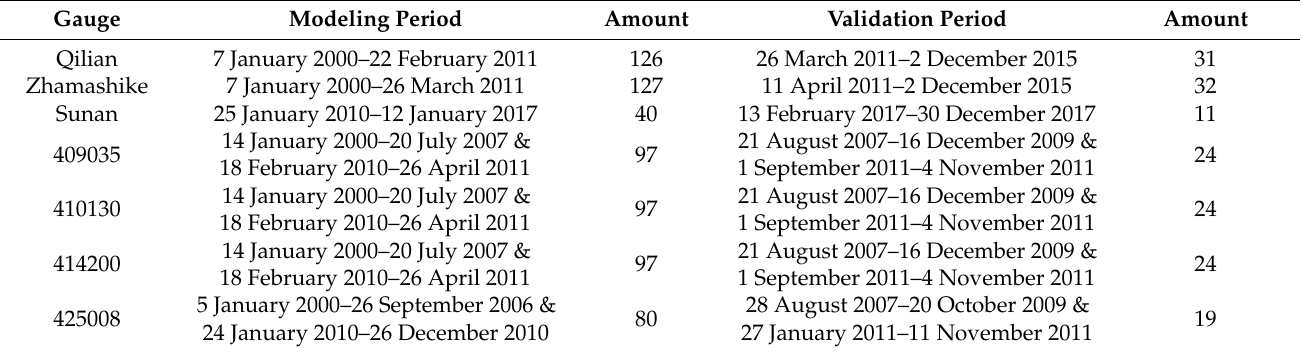
Figure 2. Observed discharge of the selected 7 hydrological gauges in the Heihe River Basin and the Murray Darling Basin. Table 1. Modelling period and validation period of each gauge, and the corresponding amount of Landsat